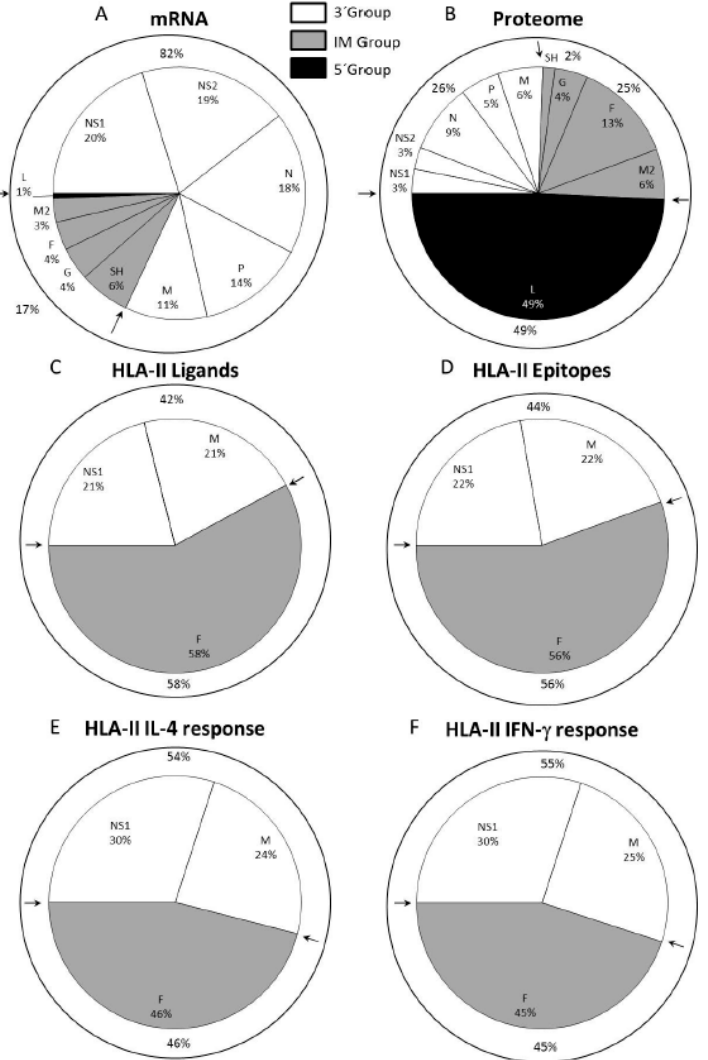
Figure 3. HLA class II ligands from HRSV identified by mass spectrometry and their relation to the viral mRNA, proteome, and T cell helper immune response. Pie chart representation of the HRSV genome indicating the relative abundance of mRNAs due to viral transcription ( A panel) and the percentage of the proteome ( B panel) for each protein, as described in Figure 1. For each protein included in its respective transcription group, the HLA class II ligand percentage identified by mass spectrometry in study [48] is shown in C panel, and the CD4 + epitope percentage from [48] is shown in D panel. The total of either IL-4 + or IFN- γ + immune helper response percentages that were detected in the HLA class II-transgenic mice in study [48] is shown in the E and F panels, respectively.